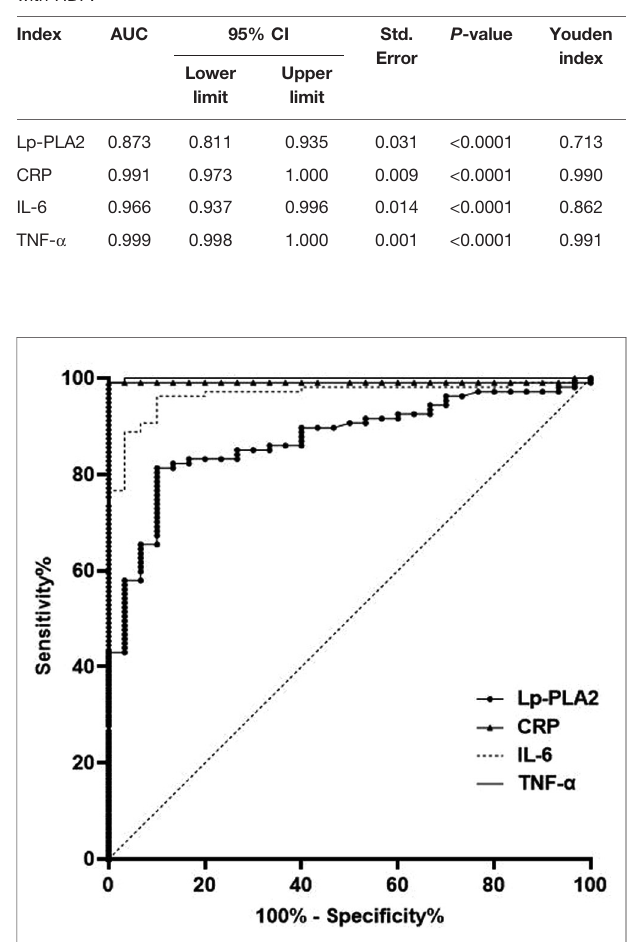
FIGURE 4 | Predictive value of serum in fl ammatory factors in pregnant women with